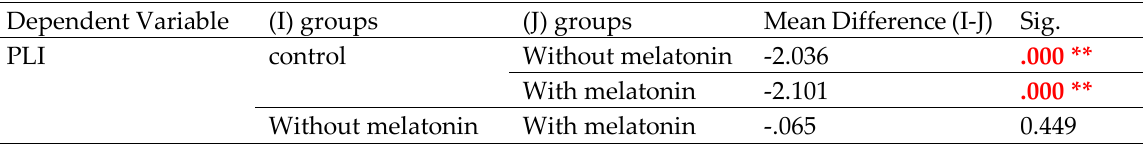
Table 2: Multiple Comparisons of PLI in the baseline visits between groups using Games-Howell. Dependent Variable